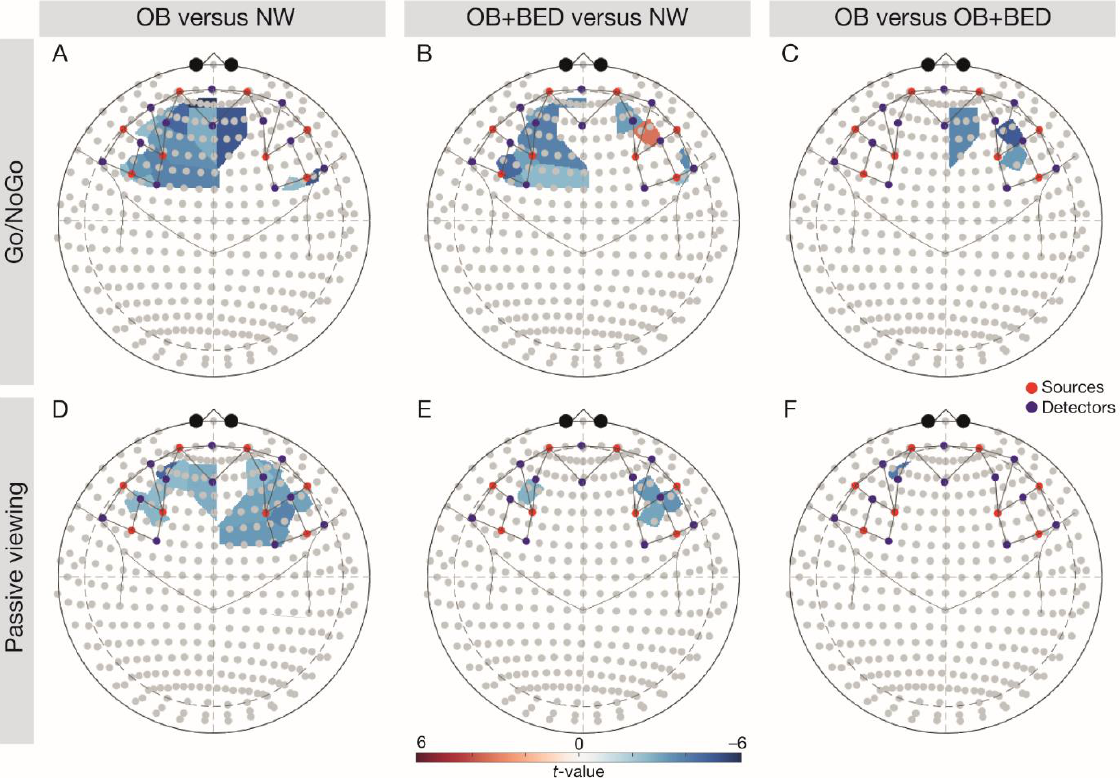
Figure 1. Follow-up comparisons of group- and task-wise differences in brain responses. Note: the upper row depicts the Go/NoGo task, with ( A ) OB vs. NW, ( B ) OB + BED vs. NW, and ( C ) OB vs. OB + BED. The lower row depicts the passive viewing task, with ( D ) OB vs. NW, ( E ) OB + BED vs. NW, and ( F ) OB vs. OB + BED. Red colouring indicates higher responses in the first-mentioned group, blue colouring indicates higher responses in the last-mentioned group. Red dots depict sources, blue dots depict detectors. NW, normal weight; OB, obesity; OB + BED, obesity with binge-eating disorder.